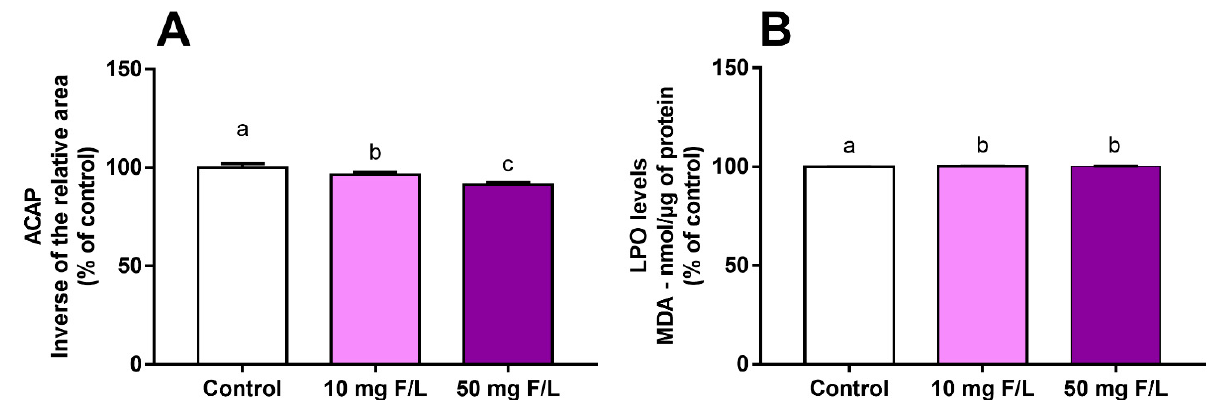
Figure 1. Effects on the cerebellum redox state of offspring after 42 days of fluoride exposure (10 mg F/L or 50 mg F/L, n = 5/group) during the gestational and lactation periods. Antioxidant capacity against peroxyl radicals (ACAP) levels as a percentage of control ( A ) and lipid peroxidation (LPO) levels measured by malonaldehyde (MDA) concentration as a percentage of control ( B ). The results are expressed as the mean ± SEM. One-way ANOVA and Tukey’s post hoc test, p < 0.05. Identical lowercase letters indicate the absence of a statistical difference.